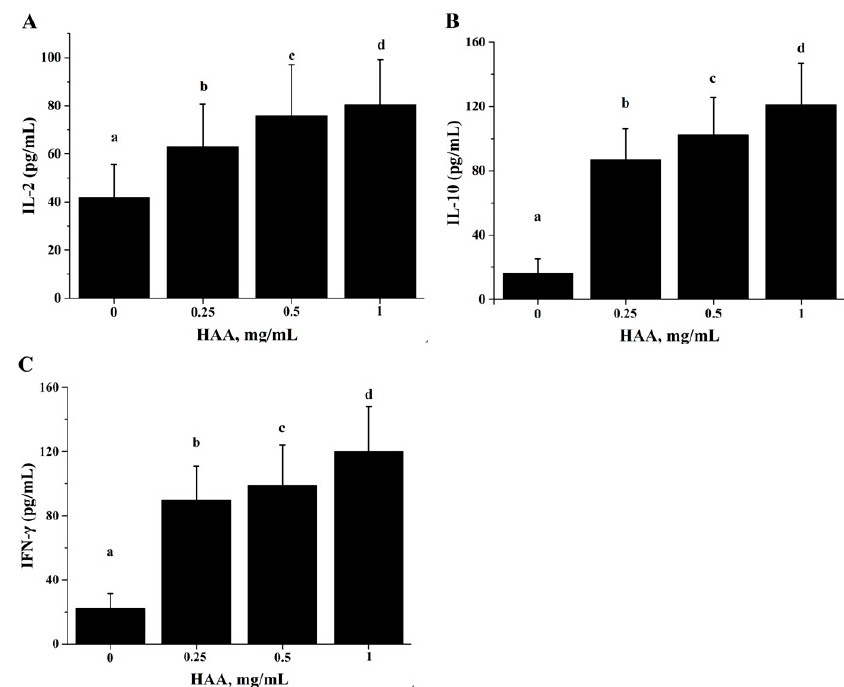
Figure 6. Effect of in vitro HAA supplementation cytokine production. Splenocytes isolated from C57BL/6 mice were incubated in the presence of HAA at 0, 0.25, 0.5 or 1 mg/mL for 4 h and then stimulated by CD3 /CD28 for 48 h. Cell-free supernatant was used to measure production of: Interleukin (IL)-2 ( A ); IL-10 ( B ); and IFN- γ ( C ) by ELISA. Values are means ± SD, n = 10. Means in a row without a common letter significantly differ as determined by one-factor ANOVA, p < 0.05.